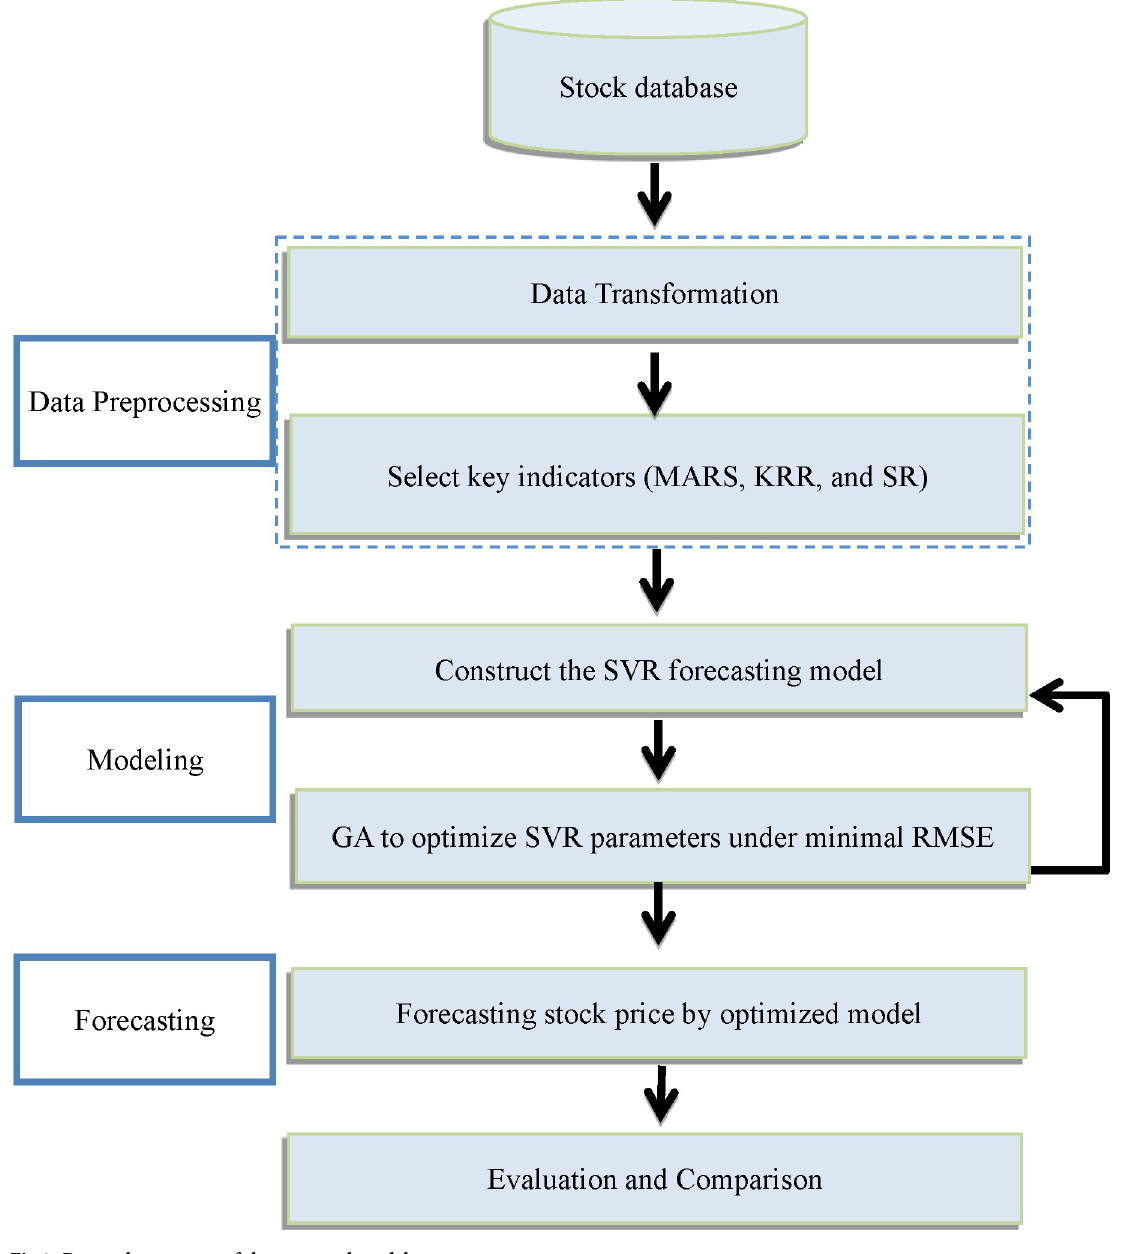
Fig 1. Research processes of the proposed